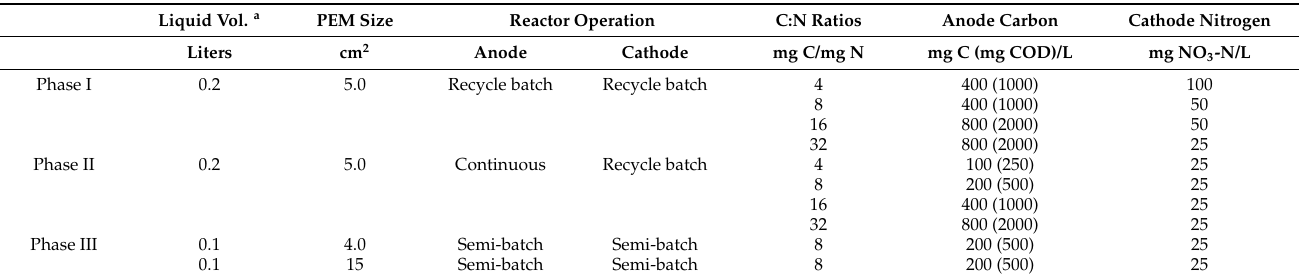
Table 1. Summary of MFC biocathode testing scheme and operation with theoretical C:N starting